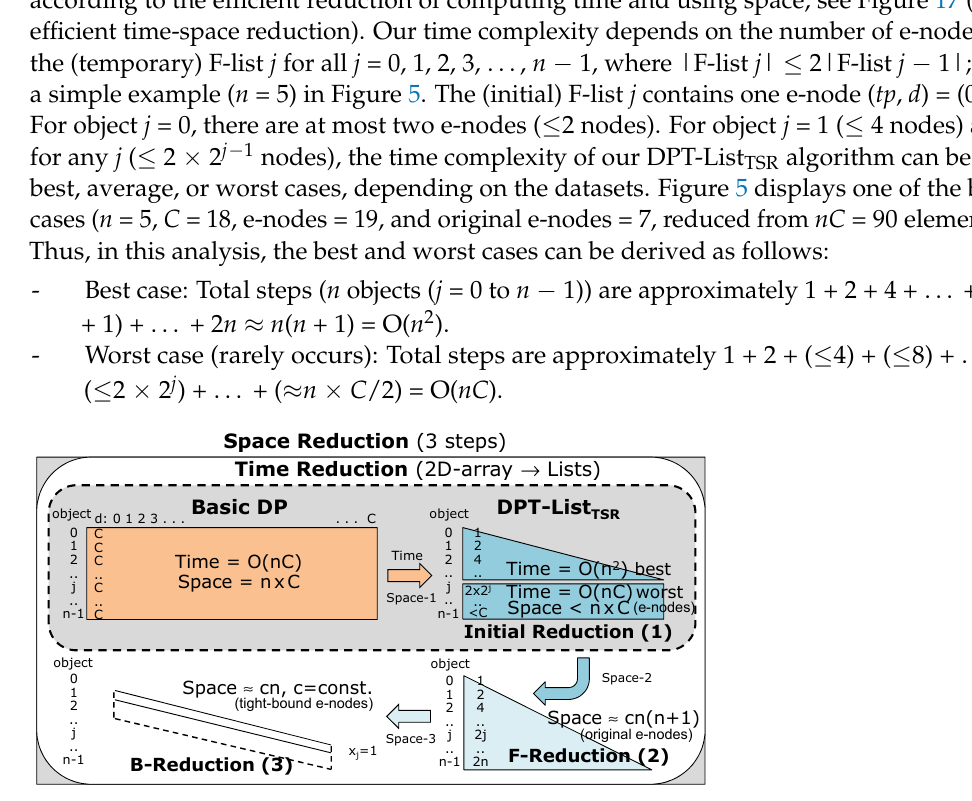
Figure 16. An example of the correct F-list j construction ( n = 5 in Figure 5): ( a ) F-list j = 1 (add a new e-node to tail of F-list j ) and ( b ) F-list j = 3 (add each of three new e-nodes to tail of F-list j ).